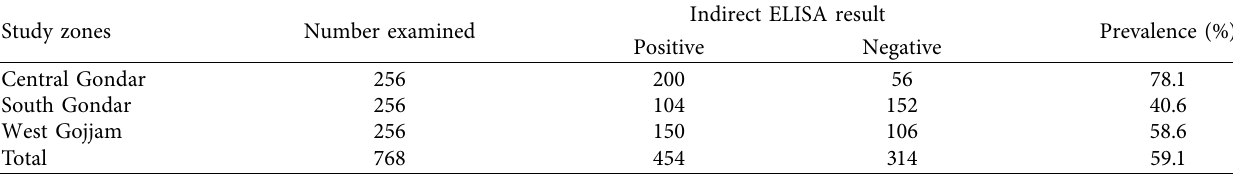
Table 2: Seroprevalence of ILTV in chickens by study zones.